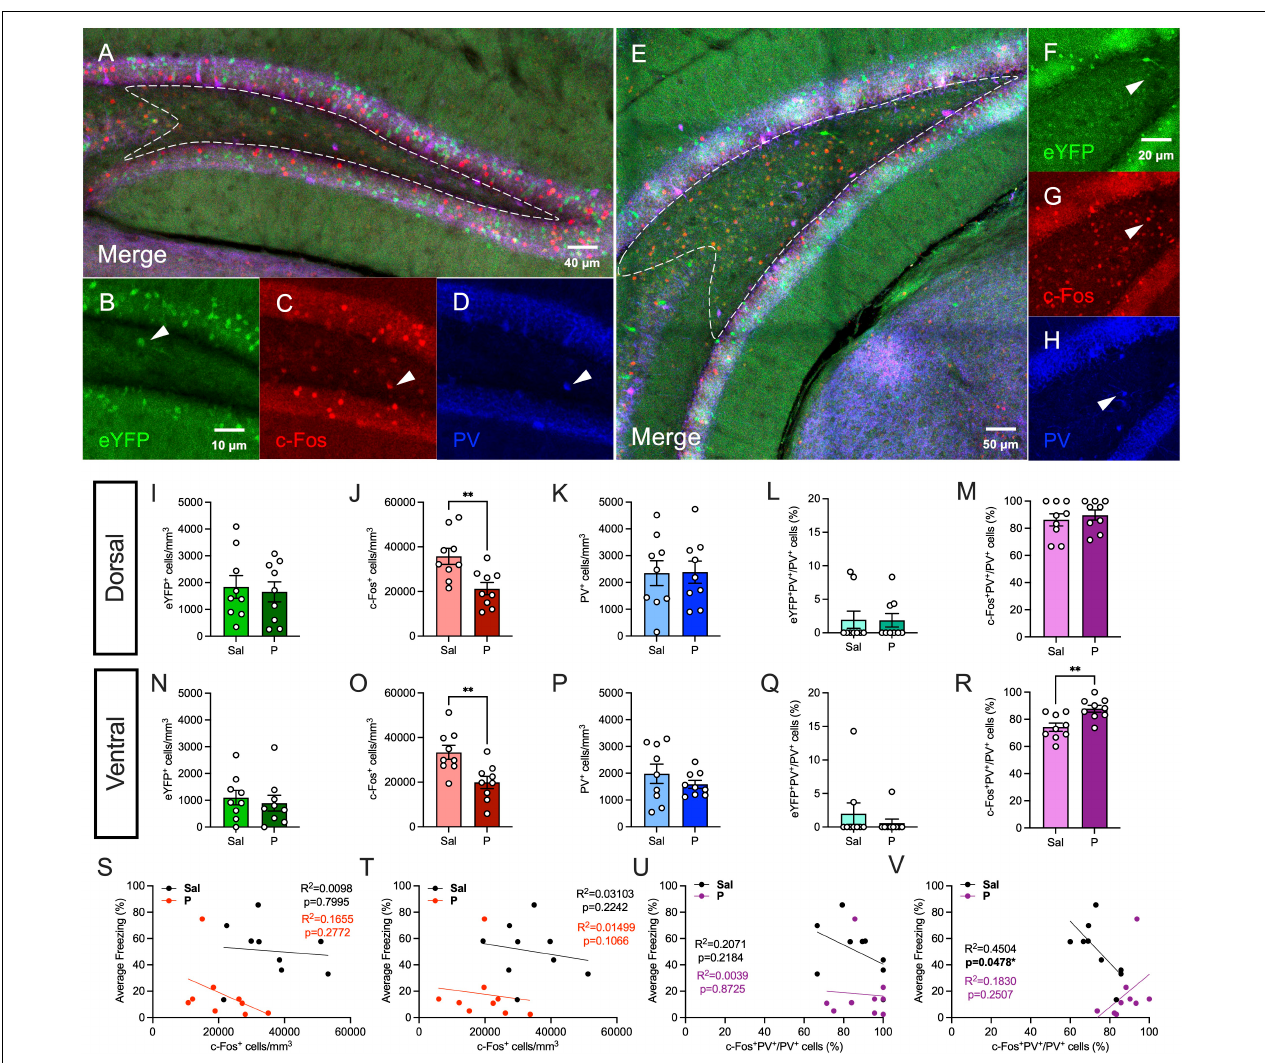
FIGURE 3 | Propranolol administration increases the activity of parvalbumin-expressing cells in the ventral, but not dorsal hilus. (A) Representative section showing eYFP (green), c-Fos (red), and PV (blue) expression in the dorsal hippocampus. A representative hilar section is outlined in white. (B) eYFP + , (C) c-Fos + , and (D) PV + cells in the dorsal hilus. (E) Representative section showing eYFP (green), c-Fos (red), and PV (blue) expression in the ventral hippocampus. A representative hilar section is outlined in white. (F) eYFP + , (G) c-Fos + , (H) PV + cells in the ventral hilus. (I) eYFP + , (J) c-Fos + , (K) PV + , (L) eYFP + PV + /PV + (%), and (M) c-Fos + PV + /PV + (%) cells in the dorsal hilus. (N) eYFP + , (O) c-Fos + , (P) PV + , (Q) eYFP + PV + /PV + (%), and (R) c-Fos + PV + /PV + (%) cells in the ventral hilus. Correlation plots of average freezing vs. (S) c-Fos + cells in the dorsal hilus, (T) c-Fos + cells in the ventral hilus, (U) c-Fos + PV + /PV + cells (%) in the dorsal hilus, and (V) c-Fos + PV + /PV + cells (%) in the ventral hilus. Error bars indicate ± SEM. ∗ p < 0.05, ∗∗ p < 0.01, ∗∗∗ p < 0.0001. eYFP, enhanced yellow fluorescent protein; PV, parvalbumin; Sal, saline; P,